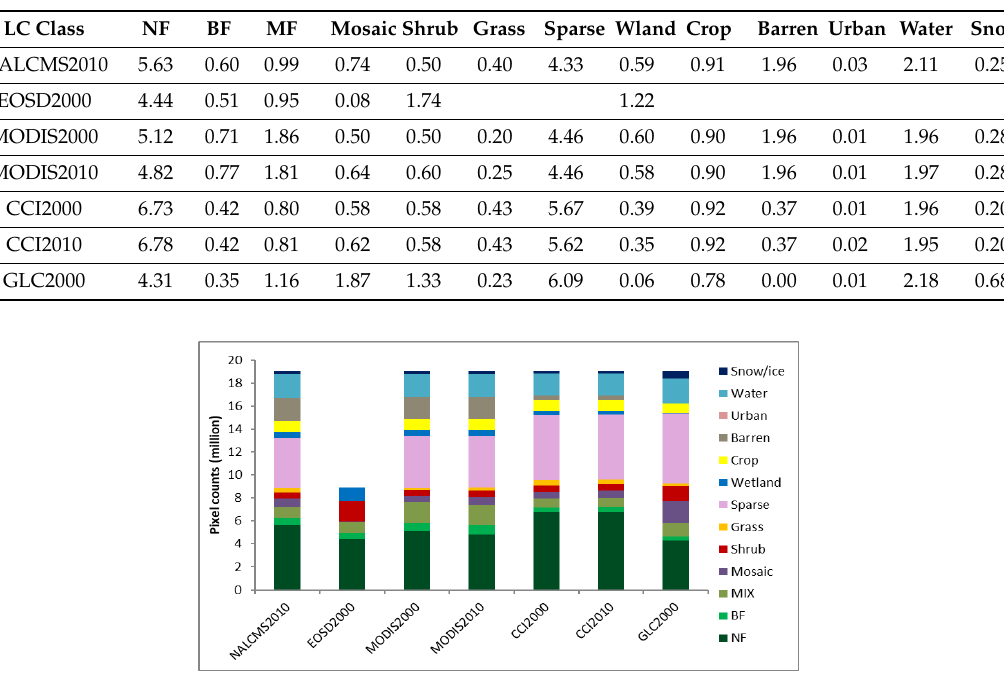
Figure 3. Maps of land cover under the common legend. The 13 classes are: 1-NF, 2-BF, 3-MF, 4-Mosaic, 5-Shrub, 6-Grass, 7-Sparse, 8-Wland, 9-Crop, 10-Barren, 11-Urban, 12-Water, 13-Snow (see Table 3 for details). Table 7. Pixel counts (million) for each of the LC classes under the common legend at 1km over Canada. Please note that EOSD is only available for forested areas.